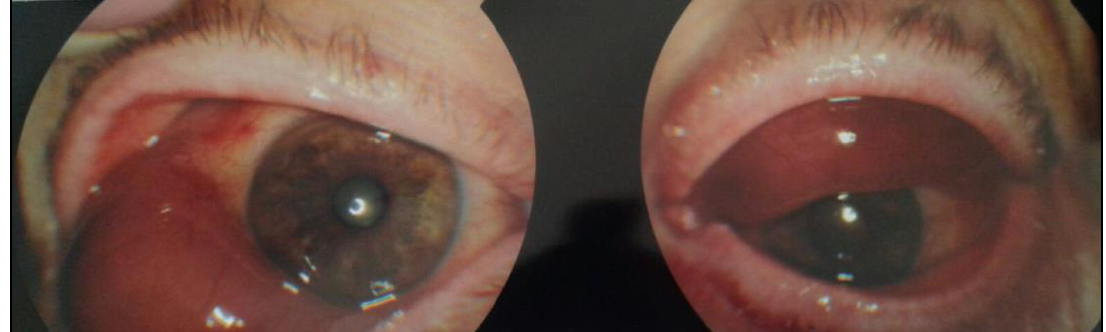
Figure 1. In vivo image showing bilateral conjunctival masses (original image from Dr E.P.).